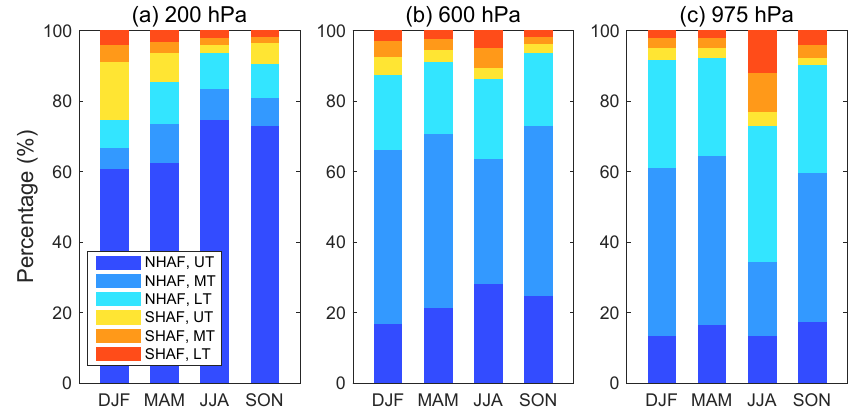
Figure 7. The fractional contribution of the imported African ozone from a layer in Africa to the total imported African ozone from all layers in Africa (in %). The layers include the lower troposphere (LT), middle troposphere (MT), and upper troposphere (UT). Each layer is further separated by hemisphere with blueish colors for NHAF and reddish colors for SHAF. The fractional contribution is shown in bars by season at (a) 200hPa, (b) 600hPa, and (c) 975hPa over Asia. The values are the 20-year means (1987–2006) from the GEOS-Chem